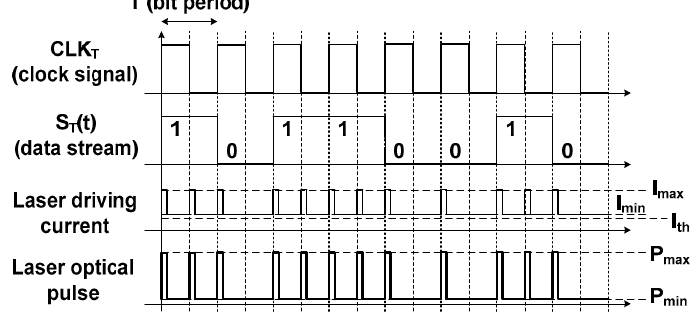
Figure 2. Example of a timing diagram describing the proposed data coding process and the corresponding laser operating conditions.